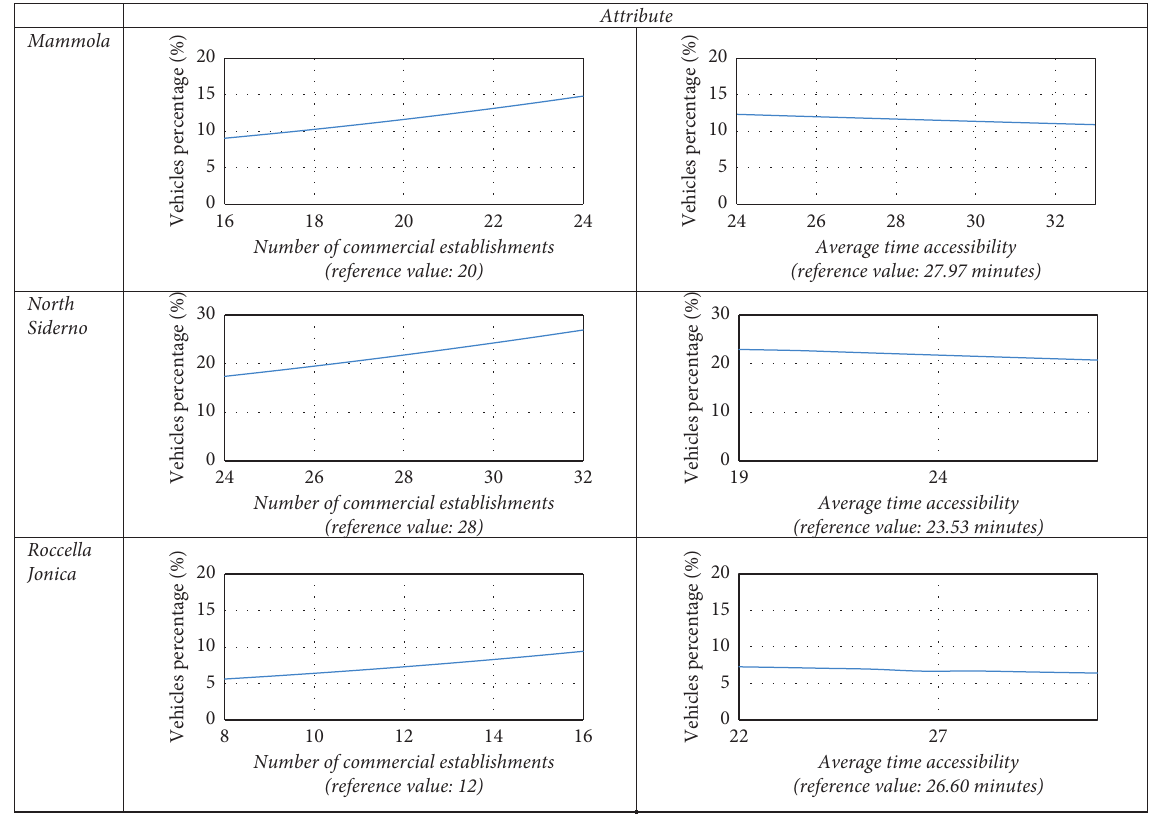
Figure 6: Probability of zonal acquisition (or percentage of freight vehicles having a zone as destination) estimated by model 7. Examples for zones of Mammola, Siderno, and Roccella Jonica. Table 9: Maximum, minimum, and mean values of model attributes.